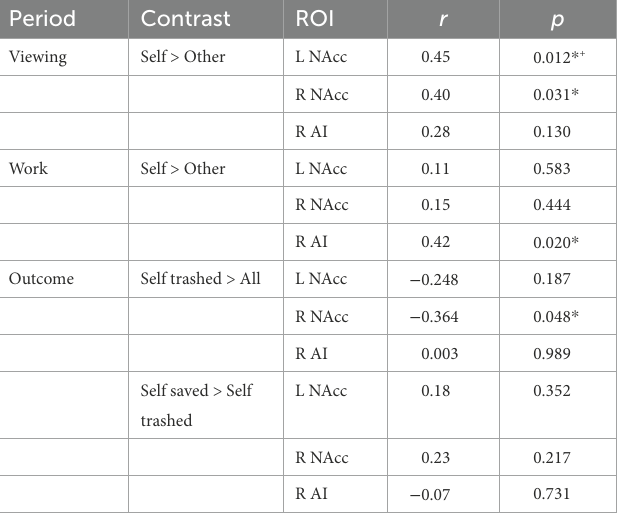
TABLE 2 Correlations of the behavioral tapping effect with 2 × 2 effects within the ROI, per period.